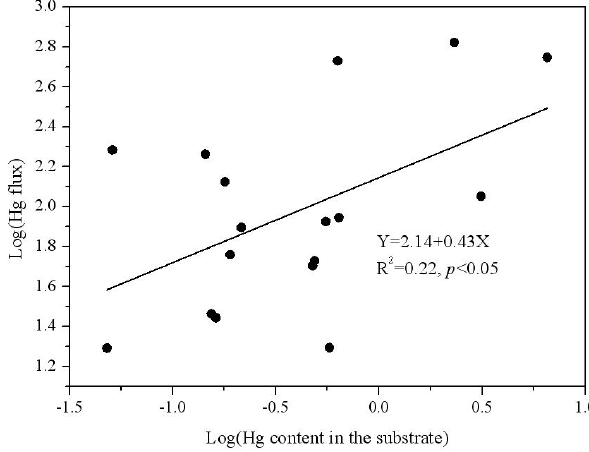
Fig. 7. Correlation between average mercury flux at different sites and mercury content in the corresponding substrates.